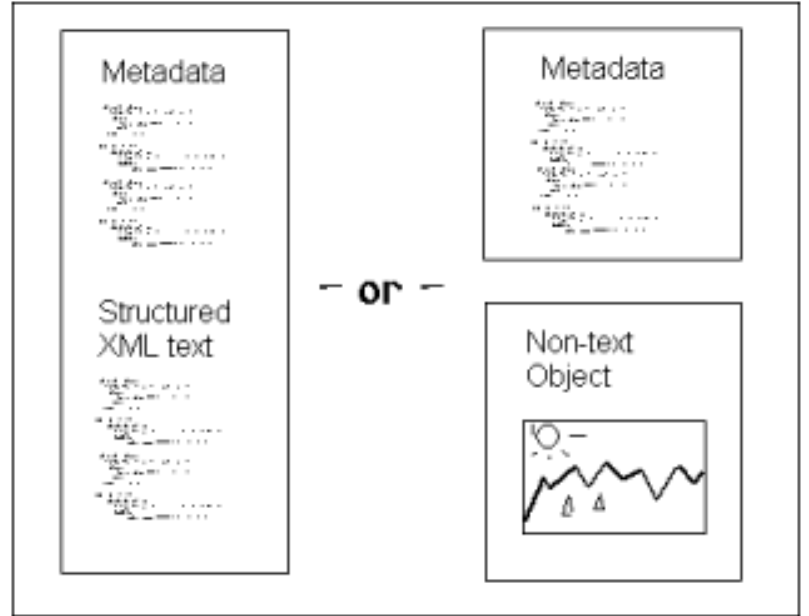
Figure 5: Learning Object